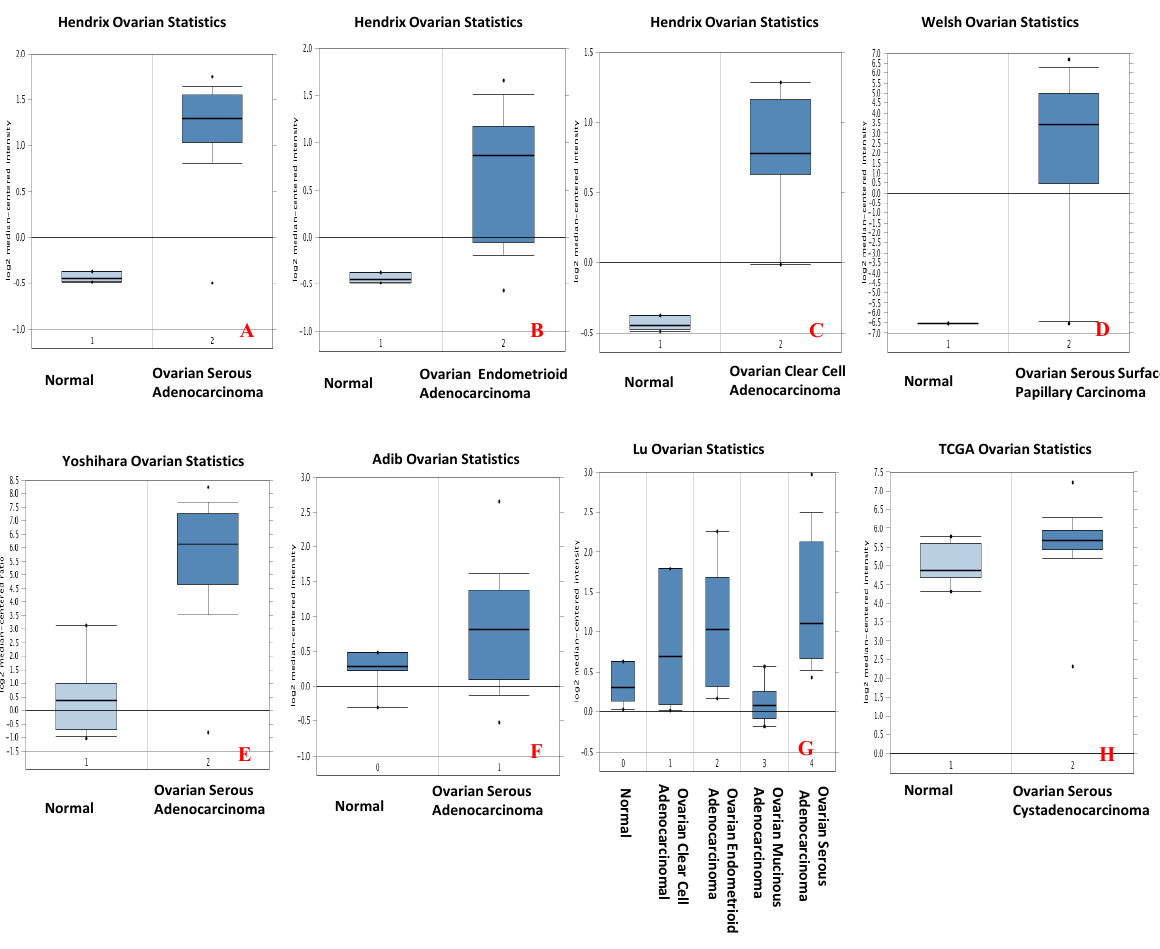
Figure 3: Expression of FOLR1 in ovarian cancer in different studies identified from the Oncomine database. (A: data form Hendrix ovarian statistics for normal tissue versus ovarian serous adenocarcinoma; B:data from Hendrix ovarian statistics for normal tissue versus ovarian endometrioid adenocarcinoma; C: data from Hendrix ovarian statistics for normal tissue versus ovarian clear cell adenocarcinoma; D: data from Welsh ovarian statistics for normal tissue versus ovarian serous surface papillary adenocarcinoma; E: data from Yoshihara ovarian statistics for normal tissue versus ovarian serous adenocarcinoma; F: data from Adlb ovarian statistics for normal tissue versus ovarian serous adenocarcinoma; G: data from Lu ovarian statistics for normal tissue versus several kinds of adenocarcinoma; H: data from TCGA databases for normal tissue versus ovarian serous cystadenocarcinoma).